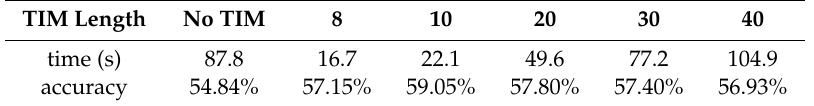
Table 2. Relationship between time interpolation model (TIM) length with time and accuracy.